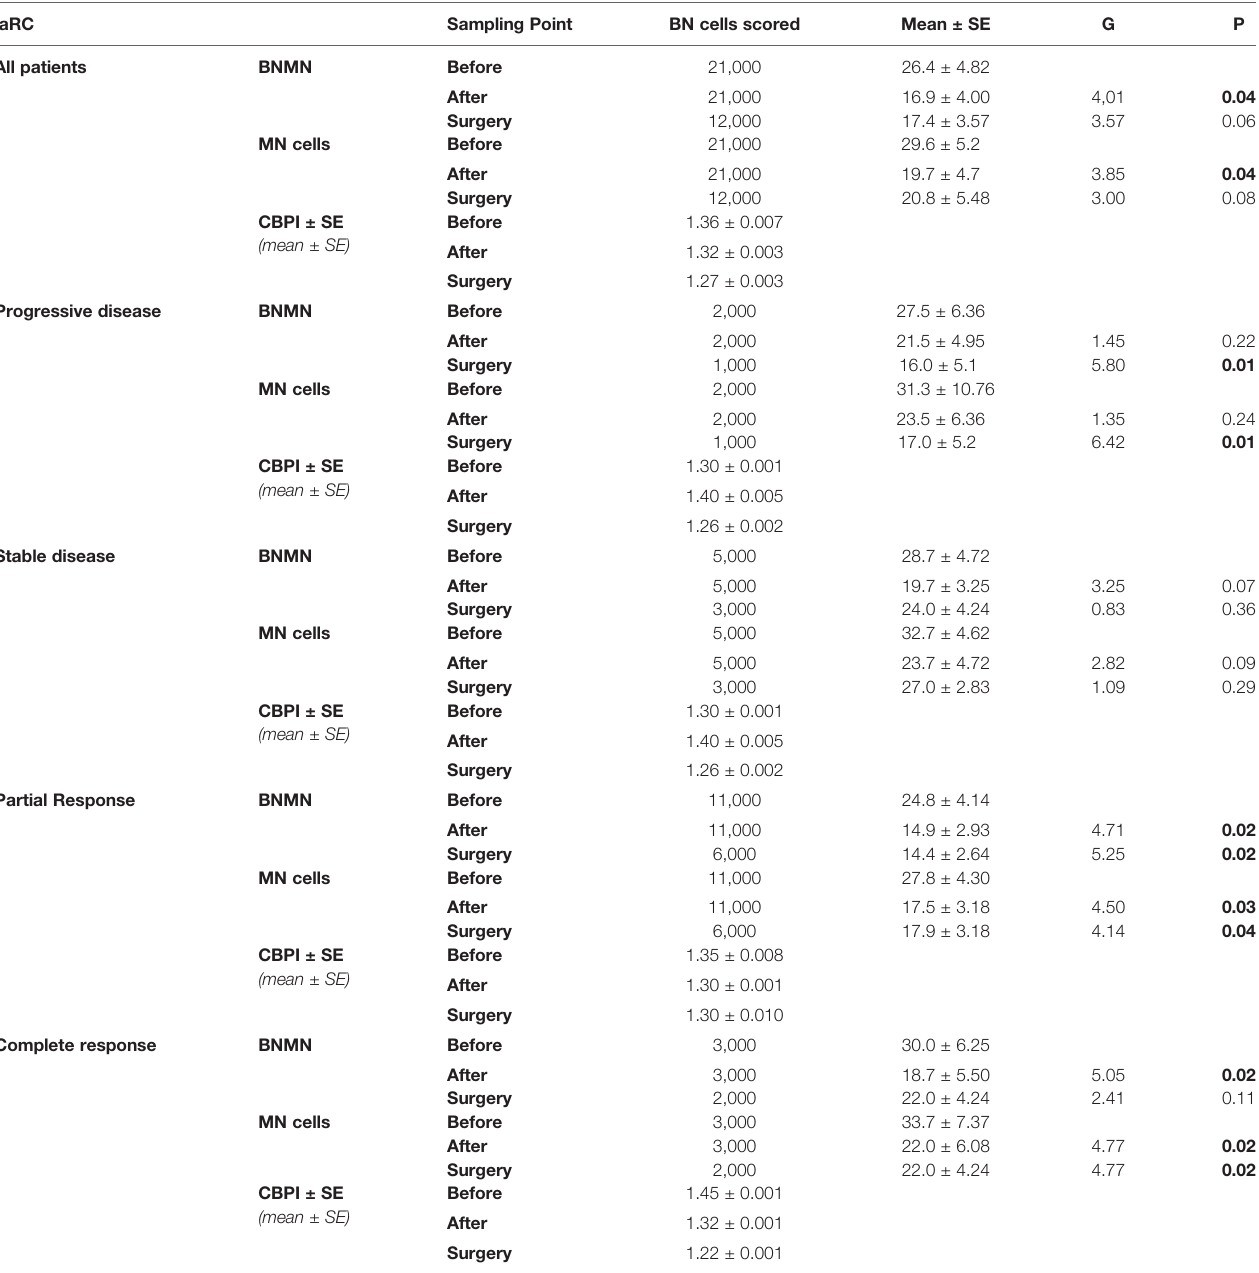
TABLE 4 | Statistical analysis of the mean BNMN and MNf of laRC patients at the beginning (before), the end of the treatment (after) and after surgery (surgery) for all laRC patients and according to their disease response (progressive disease, stable disease, partial response and complete response). laRC Sampling Point BN cells scored Mean ± SE G P All